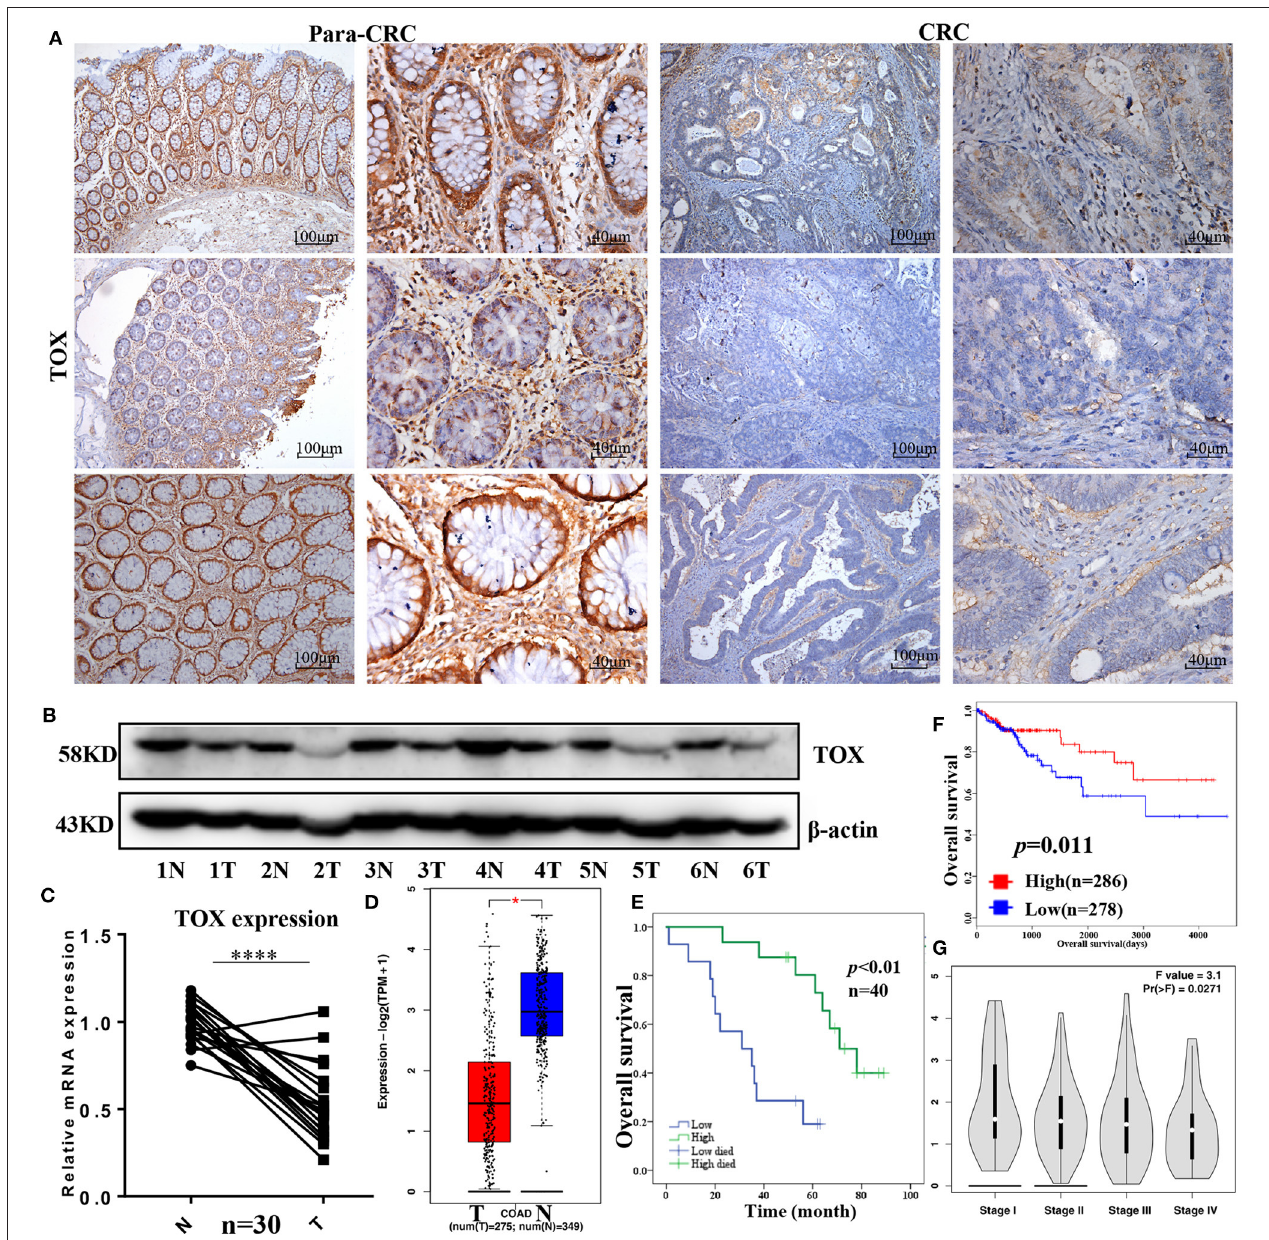
FIGURE 1 | TOX is downregulated in human CRC tissues from patients with poor survival. TOX expression was confirmed in para-CRC and CRC by IHC (A) , western blot (B) , and qRT-PCR (C) . (D) Public databases (http://gepia.cancer-pku.cn/) show the TOX expression in tumor ( n = 275) and normal ( n = 349) tissues. (E) The relationship between TOX expression and CRC patient survival in our study population as well as (F) public databases (http://tcoa.cpu.edu.cn/). (G) TOX expression was shown in different CRC stages. * p < 0.05, **** p <